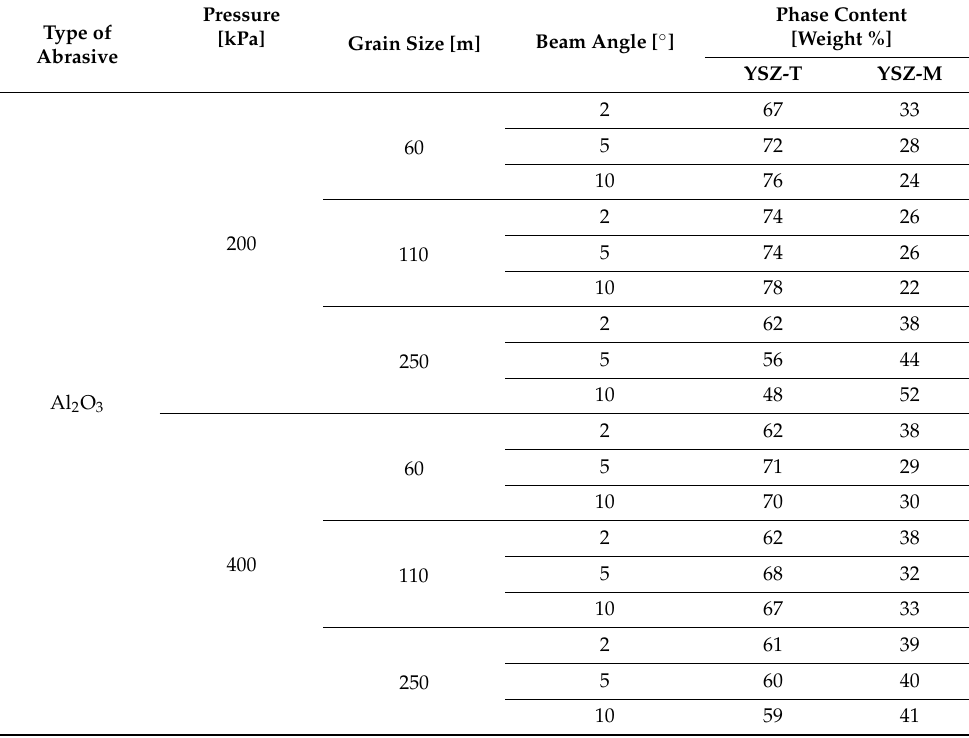
Table 2. The content of individual phases in the tested Al 2 O 3 samples.